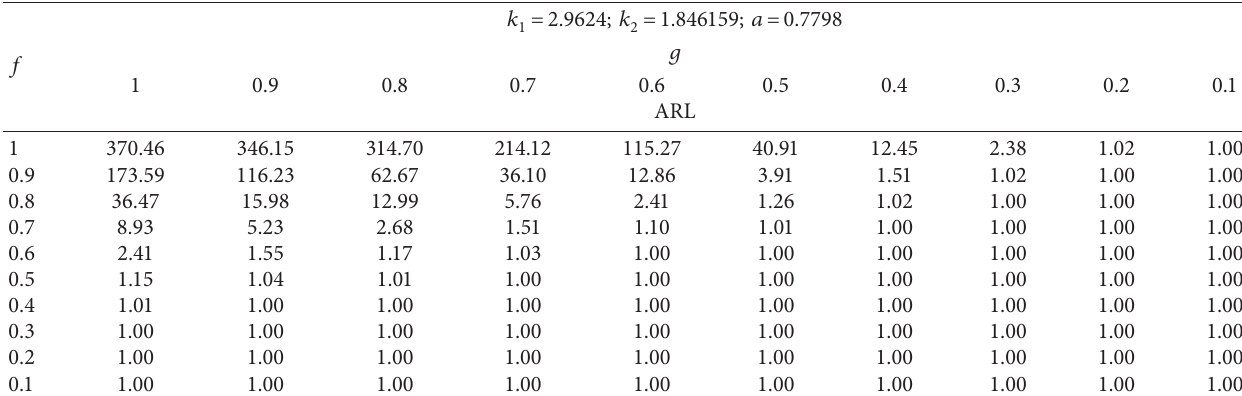
Table 6: The values of ARLs when b � 1, n � 30, and i � 2.